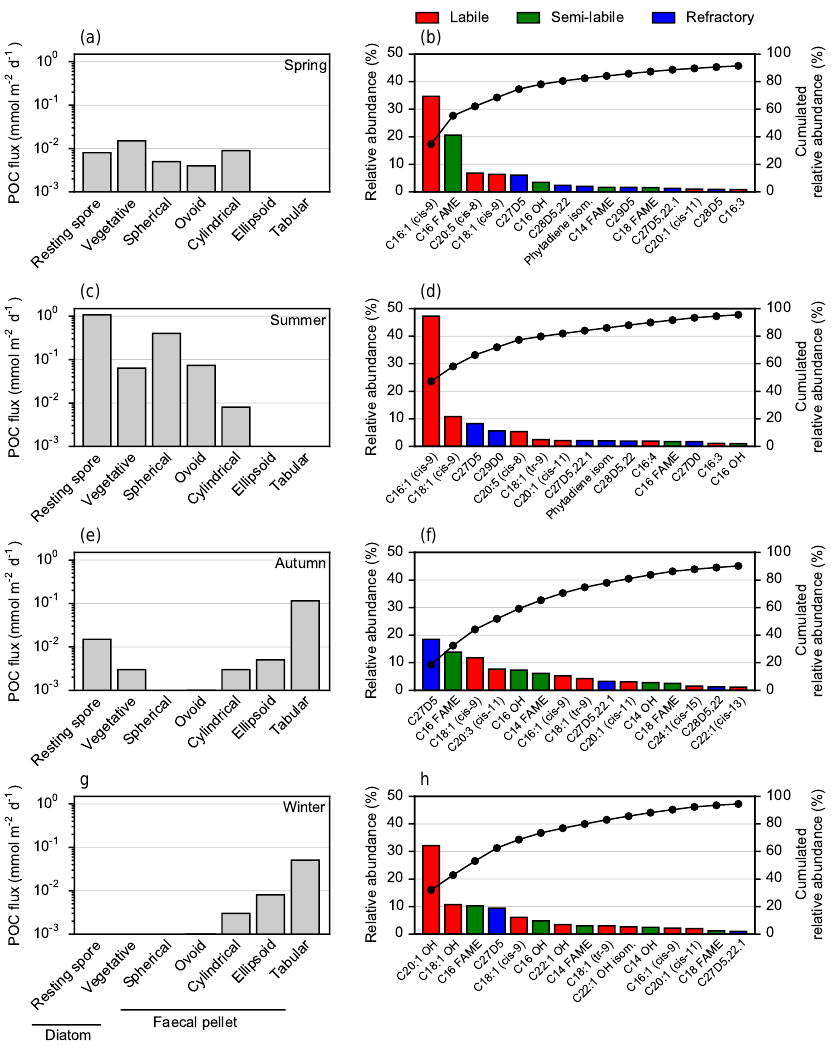
Figure 4. Seasonal evolution of carbon export vectors and associated lipid composition over the central Kerguelen Plateau (A3, 289m). Left panels: carbon export vectors from Rembauville et al. (2015). Right panels: sorted relative abundance (coloured bars) and cumulated relative abundance (dots) of major lipids. (a) and (b) cups 1–3, (c) and (d) cup 9, (e) and (f) cup 11, (g) and (h) cup